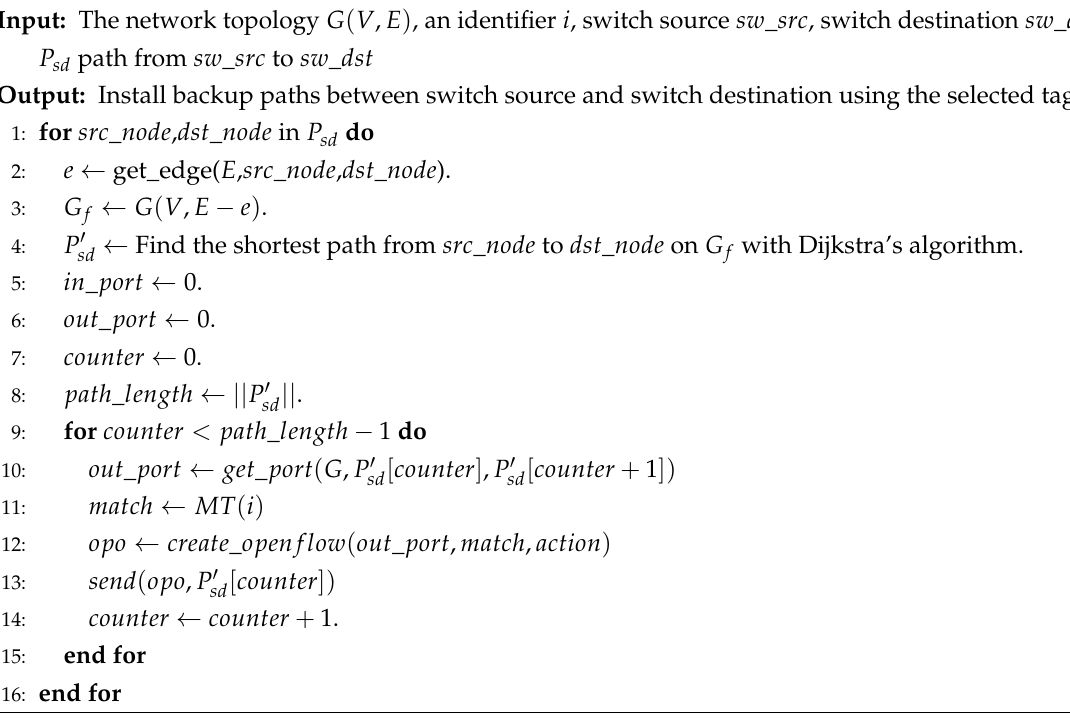
Algorithm 3 installs the backup paths for the primary path. The idea here is proactive install rules that avoid any unavailability in the primary path. Algorithm 3 Install backup